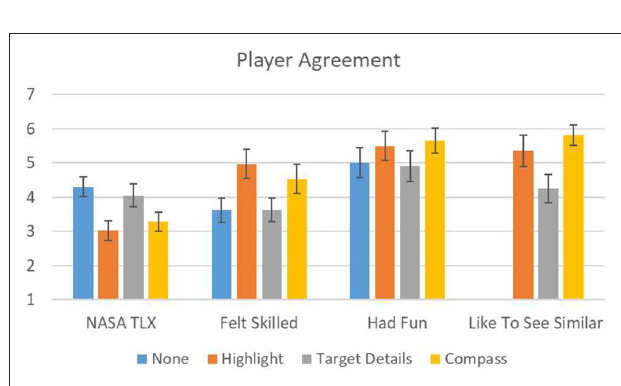
FIGURE 7 | Agreement ratings by Assistance Technique. NASA TLX scores lower is better, other ratings higher is